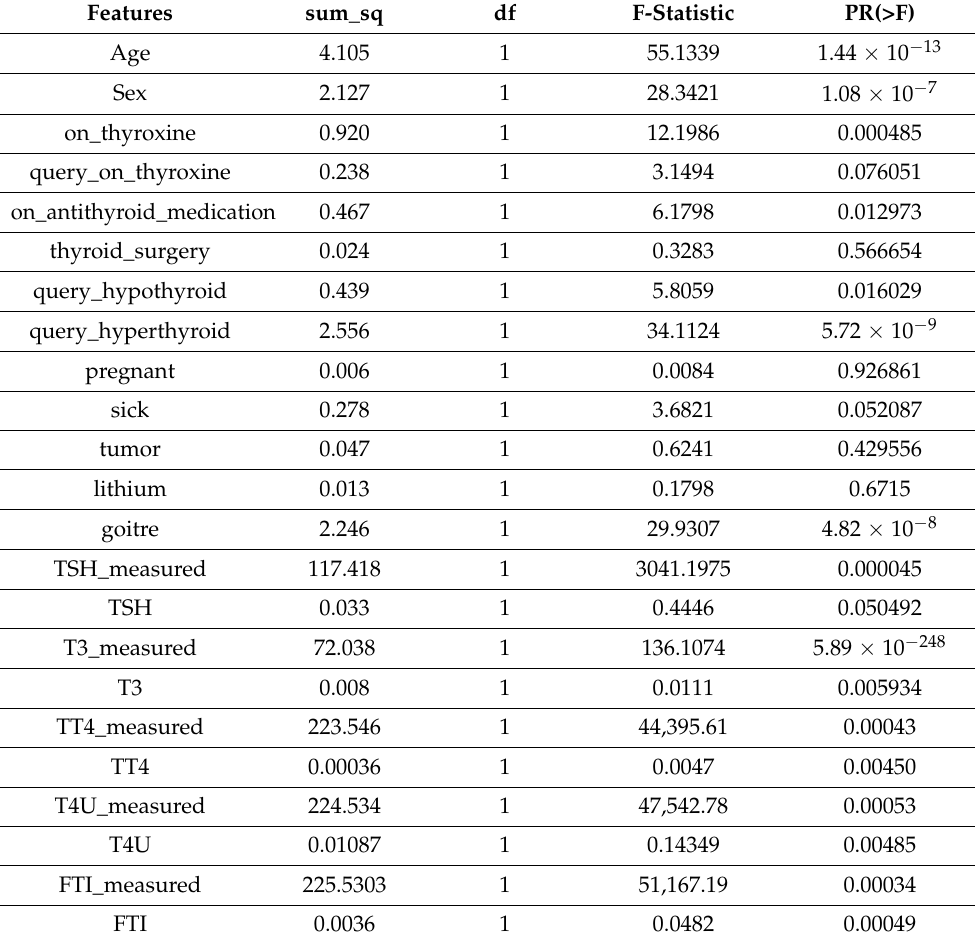
Table 1. Attribute analysis with the ANOVA test.